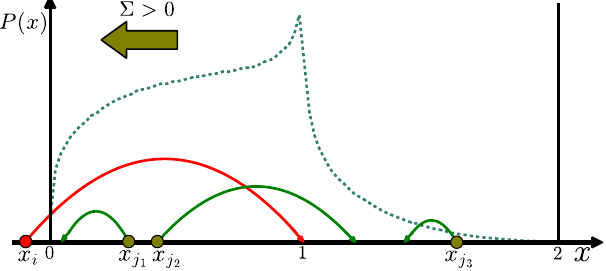
FIG. 1. Mean-field model: An unstable site (red line) returns to x 1 from x < 0 after a time τ i ¼ i r . Concomitantly, other sites implement a drift toward negative x to conserve the mean stress and a random jump of symmetric distribution w ð ξ Þ . The dashed line represents P ð x Þ , assuming Σ > 0 . A pseudogap is repre- sented at x ¼ 0